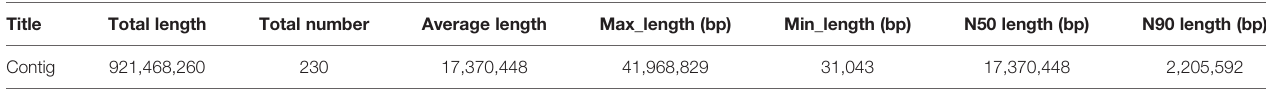
TABLE 1 | Summary of the assembled genome.